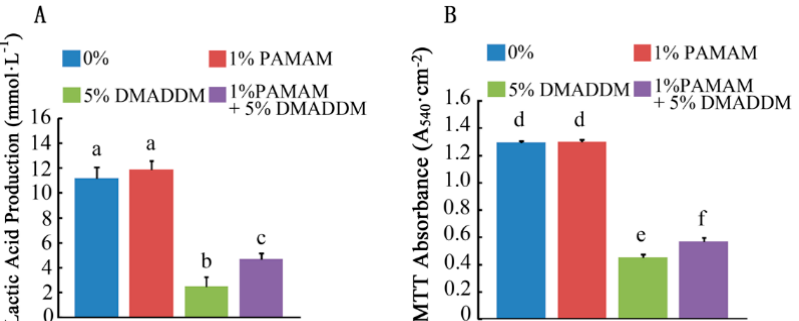
Figure 3. Lactic acid production and metabolic activity. ( A ) Lactic acid production by three-species biofilms adherent on the disks (mean ± sd; n = 6); ( B ) MTT assay of metabolic activity of biofilms adherent on the composites (mean ± sd; n = 6). Bars with the same letter indicate values that have no significant difference ( p > 0.1) and those with the dissimilar letters indicate significant difference ( p < 0.05).